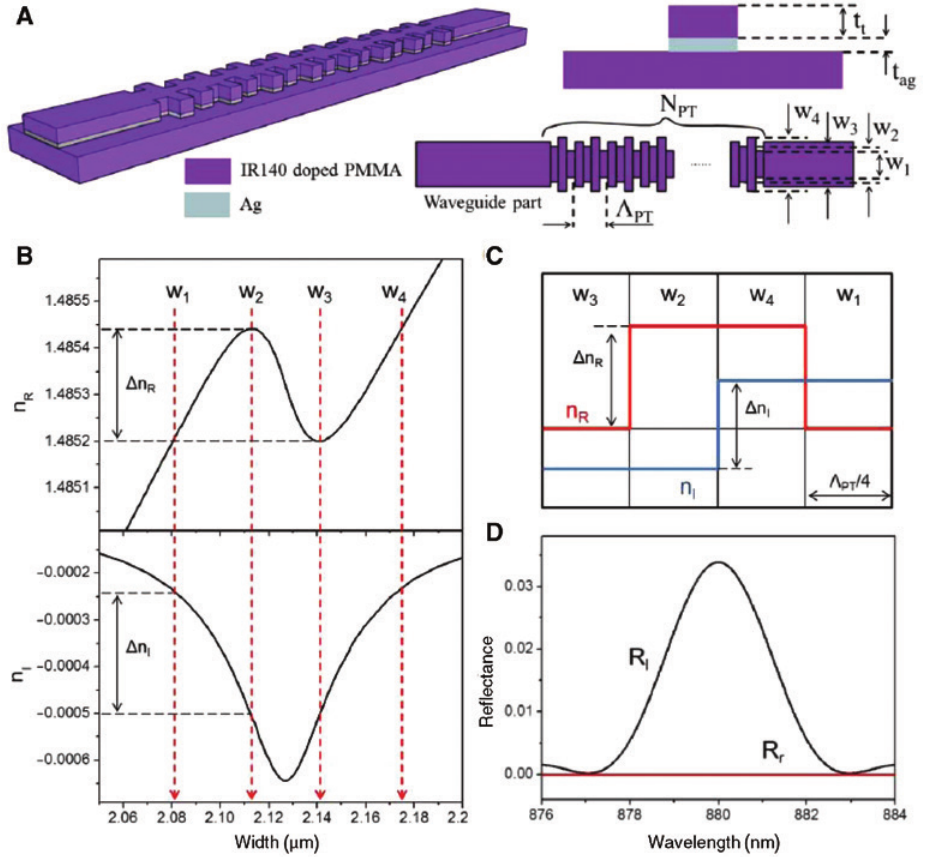
Figure 5: Optical properties of a designed passive unidirectional reflectionless DL-LRSPP PT -symmetric grating structure. (A) 3D view of a DL-LRSPP PT -symmetric grating structure. (B) Real and imaginary parts of effective index near the n the ss b0 (fundamental) and sa b3 (asymmetric high-order) modes. Vertical red dashed lines indicate four widths selected for a PT -symmetric grating. (C) Schematic of the real and imaginary index distribution within one period. (D) Reflectance from the left side R R of a passive PT -symmetric grating operating at the EP r